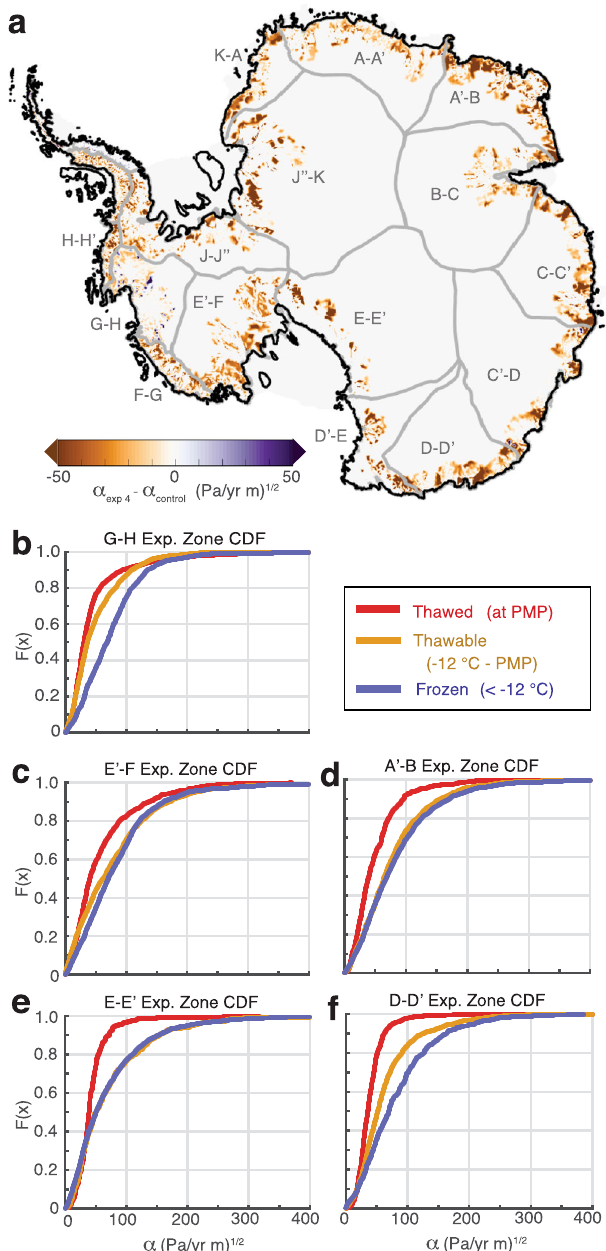
Fig. 3 | Basal friction coef fi cient distributions. a Prescribed change in basal friction coef fi cients for Exp. 4 ( α exp4 (cid:1) α control ) in thawable-bed regions of